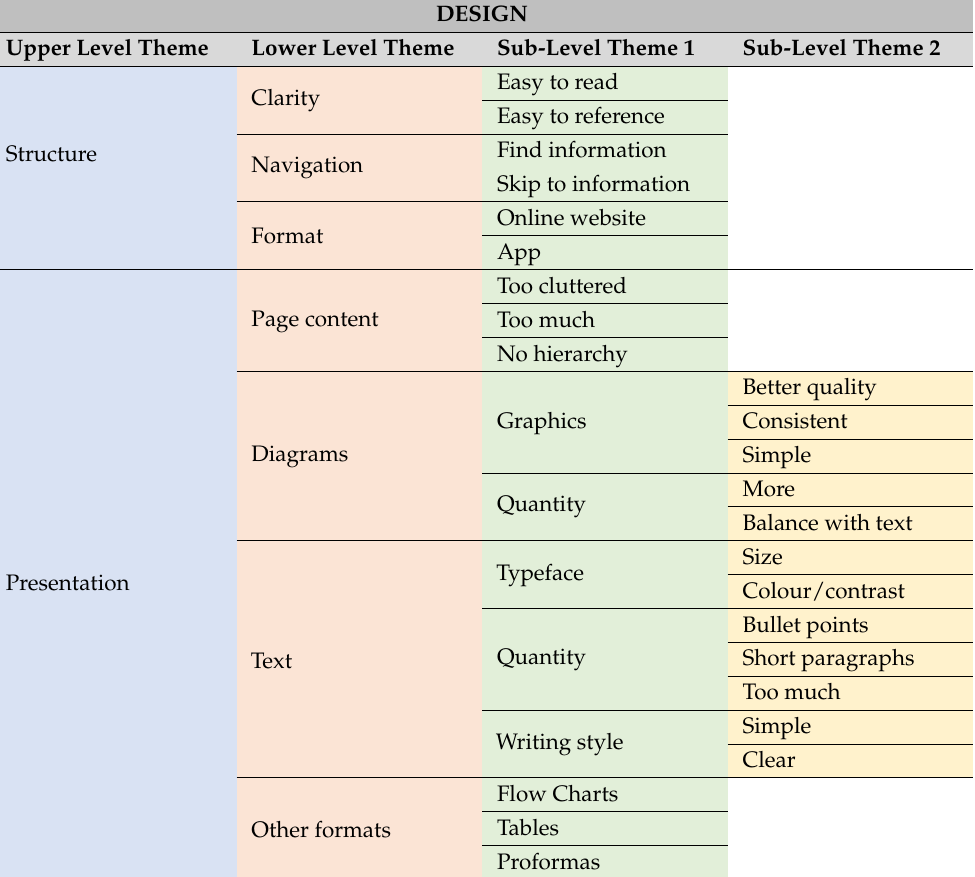
Table 3. Summary of combined FG data regarding the “Design” of the ABDG [5].